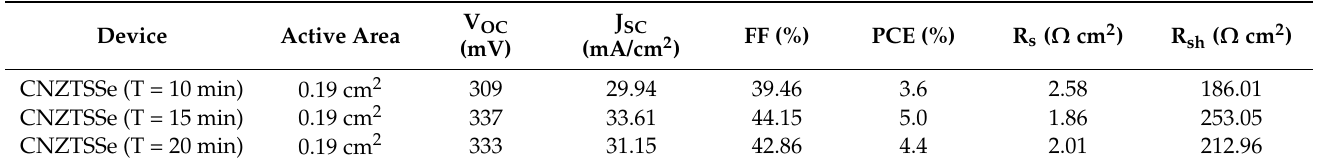
Table 3. The main photovoltaic parameters of CNZTSSe solar cells were prepared at the selenidation time of 10, 15, and 20